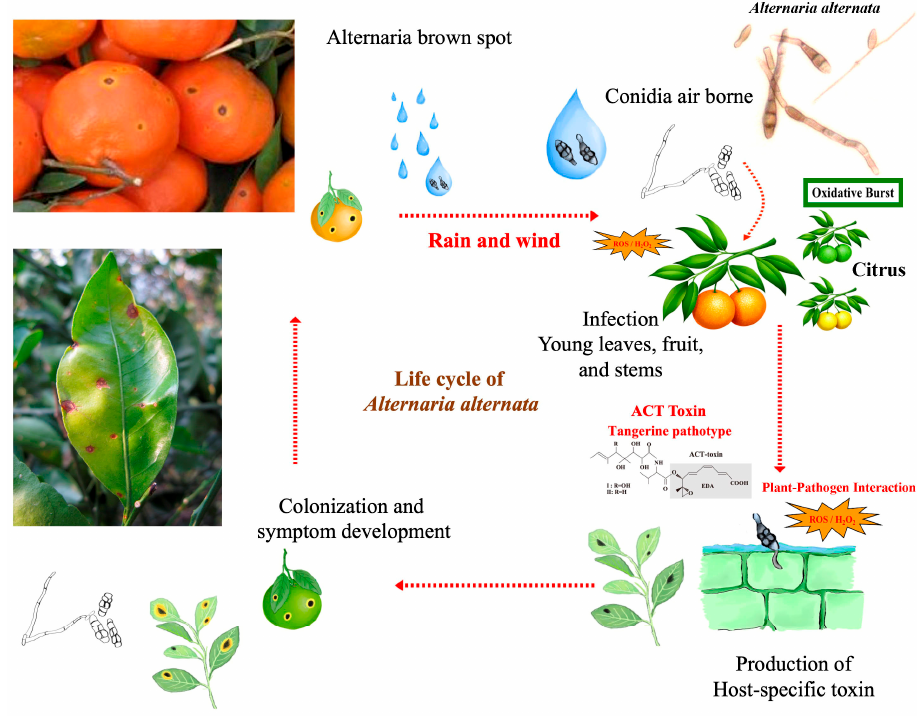
Figure 1. Life cycle of Alternaria alternata , the causal agent of citrus Alternaria brown spot. Despite the fact that recent studies have made significant progress in the characteristics of individual A. alternata pathogenicity factors such as ROS detoxication regulator GPx3 [24], Glr1, Tlr1, Tsa1 [25], ACT toxin regulator ACTR [26], cysteine regulator MetR [27], MetB, MetC, MetX [28], ROS stress regulator Yap1 [29], as well as its genome with ACT toxin gene clusters [30,31], the gene expression profile of A. alternata during infection, as well as its physiological and metabolic changes have been only sparsely studied. To this end, we performed comparative transcriptome analysis to evaluate the gene expression patterns of A. alternata during interaction with the host plant. In particular, RNA-Seq was employed to examine the early stages of transcriptome analysis of A. alternata 12-, 24-, and 48 h post-inoculation (hpi), compared with uninoculated controls. Our results revealed a comprehensive list of differentially expressed genes of A. alternata during infection of citrus, which may shed light on the events occurring early in the infection